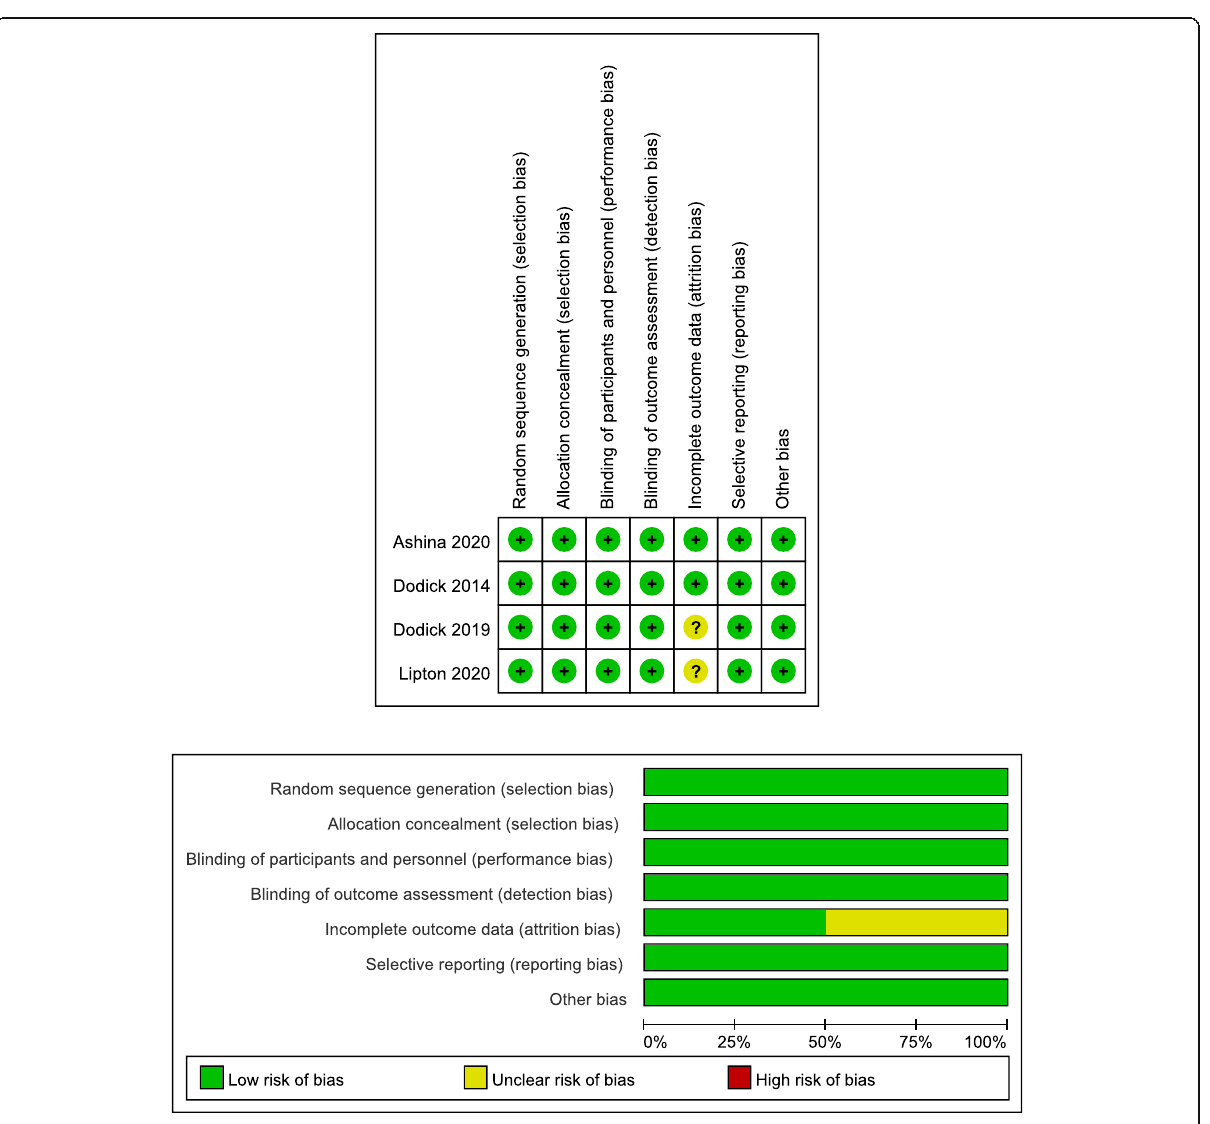
Fig. 8 Summary table for potential bias analysis for included